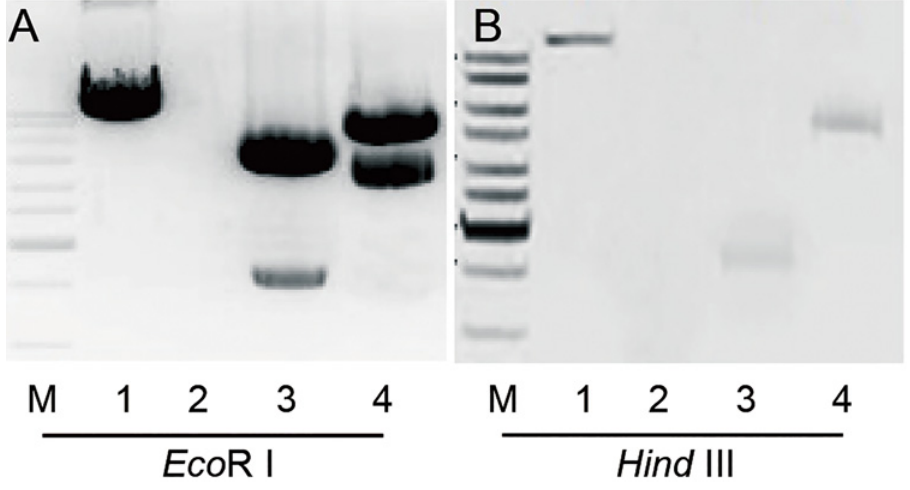
Fig 3. Southern blot analysis of OsARG gene copy number in the genomes of transgenic cotton plants. The probe was labeled with the radioactive isotope [ α - 32 P] dCTP. (A) Two copies of OsARG were integrated into the ARG-26 genome. (B) One copy of OsARG was integrated into the ARG-38 genome. The under labels indicate the following samples: M, marker. 1, positive control. 2, negative control. 3, genomic DNA digested using Eco RI. 4, genomic DNA digested using Hind